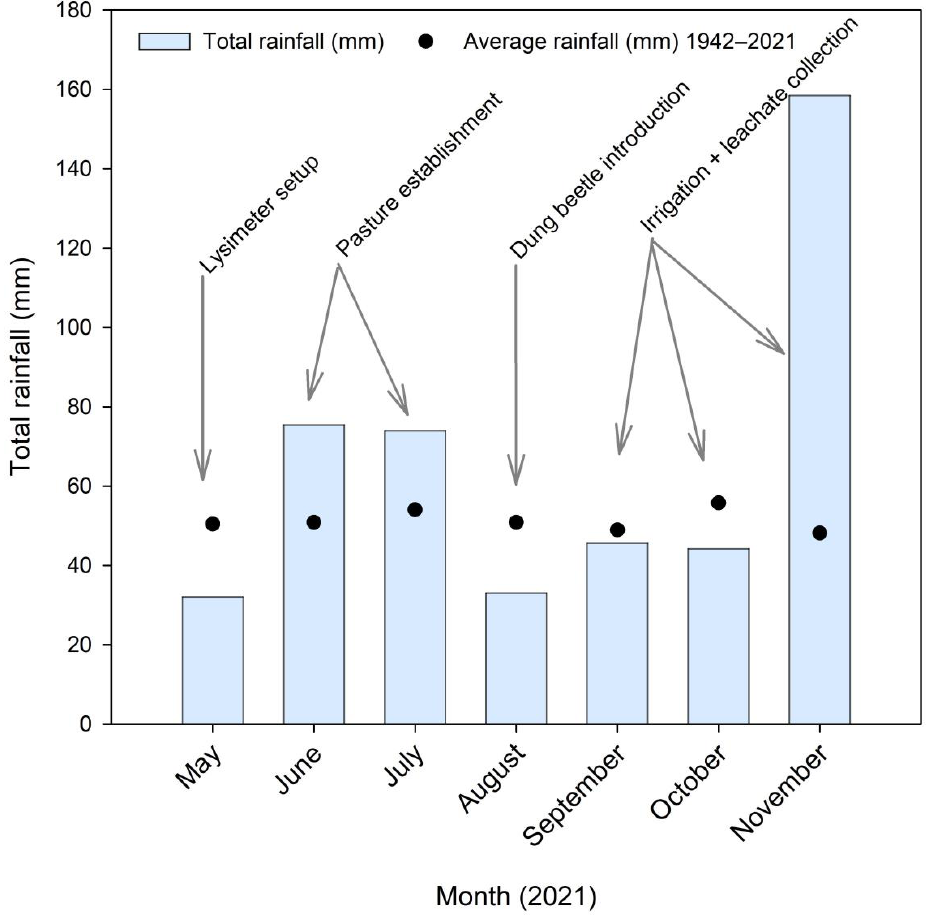
Figure 1. Total rainfall as contrasted with long-term average rainfall in Wagga Wagga, NSW over the pasture growing season of May – November 2021 [32].